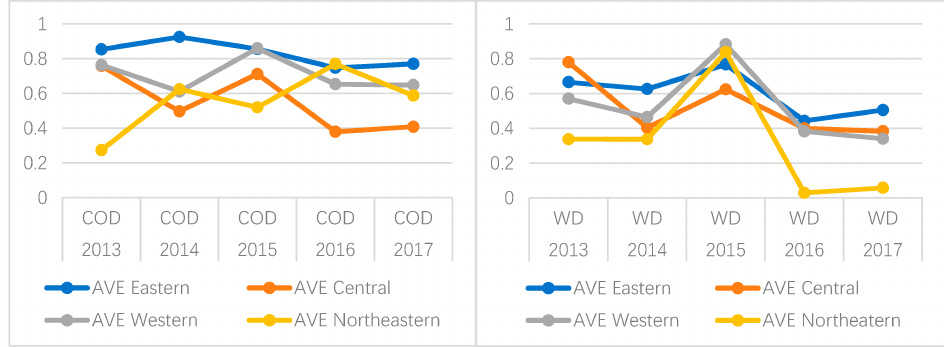
Figure 5. Chemical oxygen demand (COD) and water diseases (WD) line charts from 2013 to 2017.